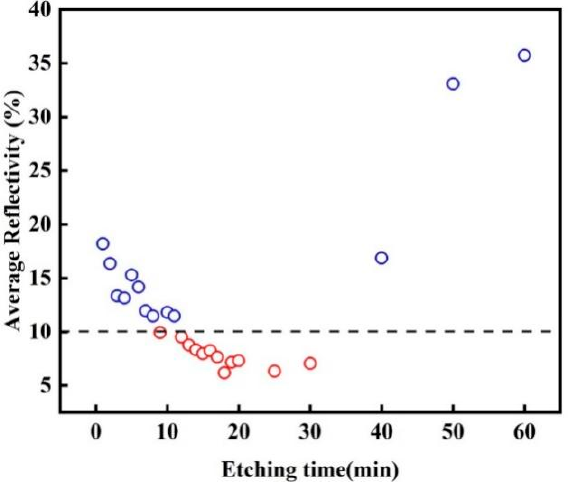
Figure 8. Effect of etching time on results in Ag@PVP–ACE with 0.875 M NH 4 HF 2 , 94 mM AgNO 3 and 0.6 M H 2 O 2 . All samples were etched for 6–60 min at 65 °C.